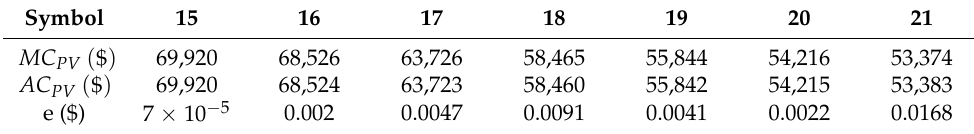
Table 6. The estimated error between 15 and 21